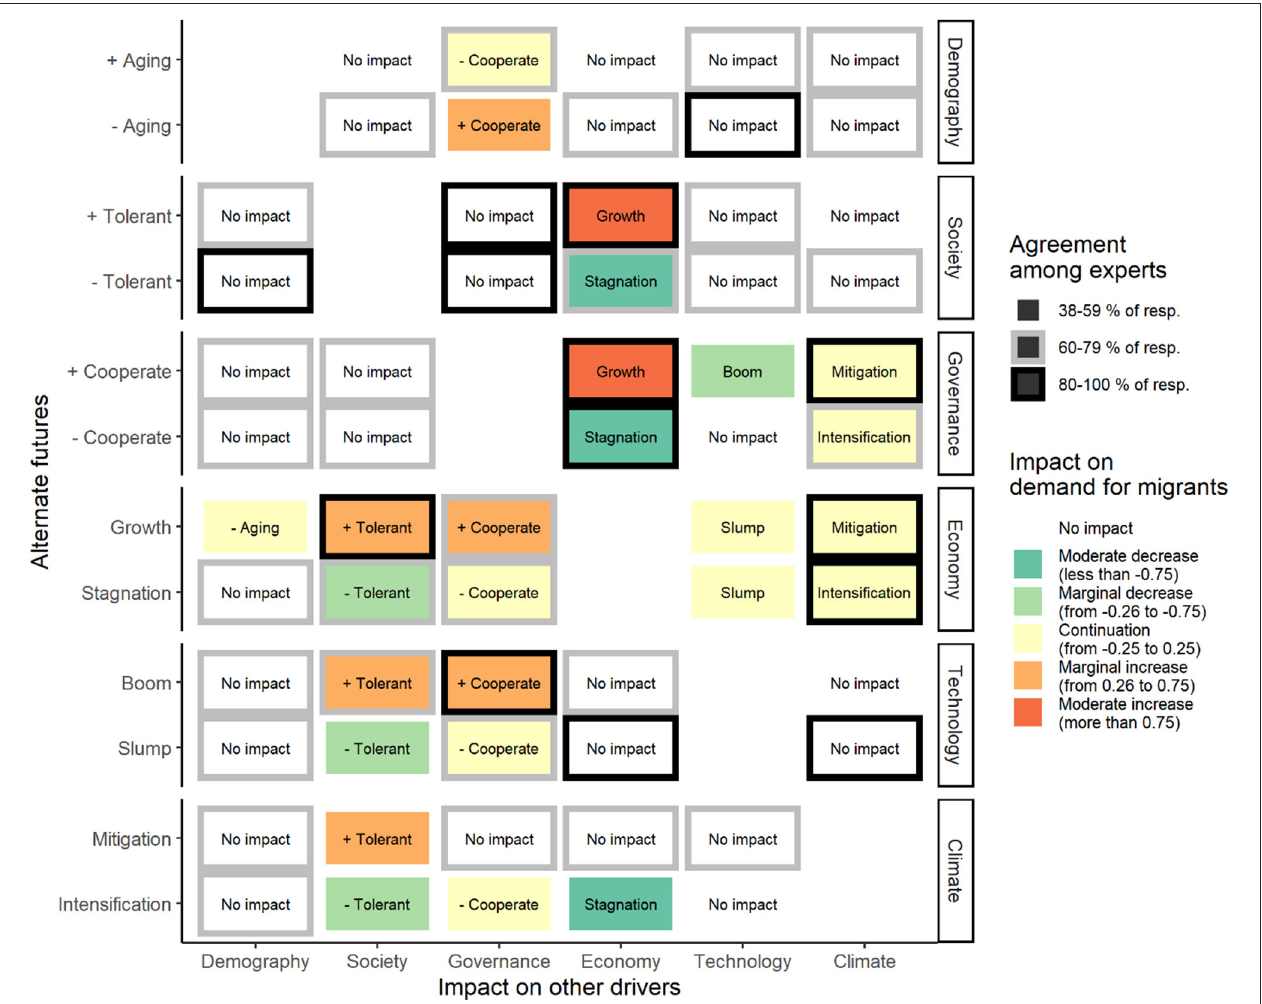
FIGURE 2 | Impact of alternate futures on other drivers and resulting impacts on demand for migrants in Europe, with levels of agreement among migration scholars. Rows represent alternate futures (left y-axis) in each driver (right y-axis). Columns represent the impacted drivers. The direction of the impact is indicated in boxes which reflect the most commonly chosen answer among migration scholars. Different levels of darkness of the frame around each box indicate the proportion of respondents who chose the indicated direction of impact. Colors show the size of the impact on migration of each future indicated in the boxes, averaged among all migration